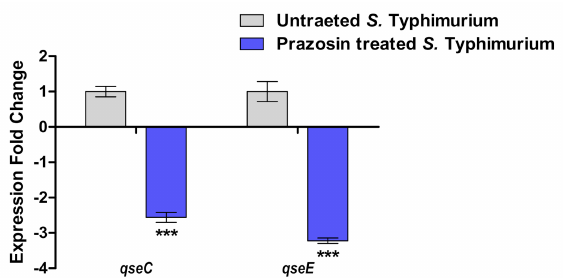
Figure 5. Prazosin interferes with Salmonella adrenoreceptor sensors. Prazosin at sub − MIC signifi-